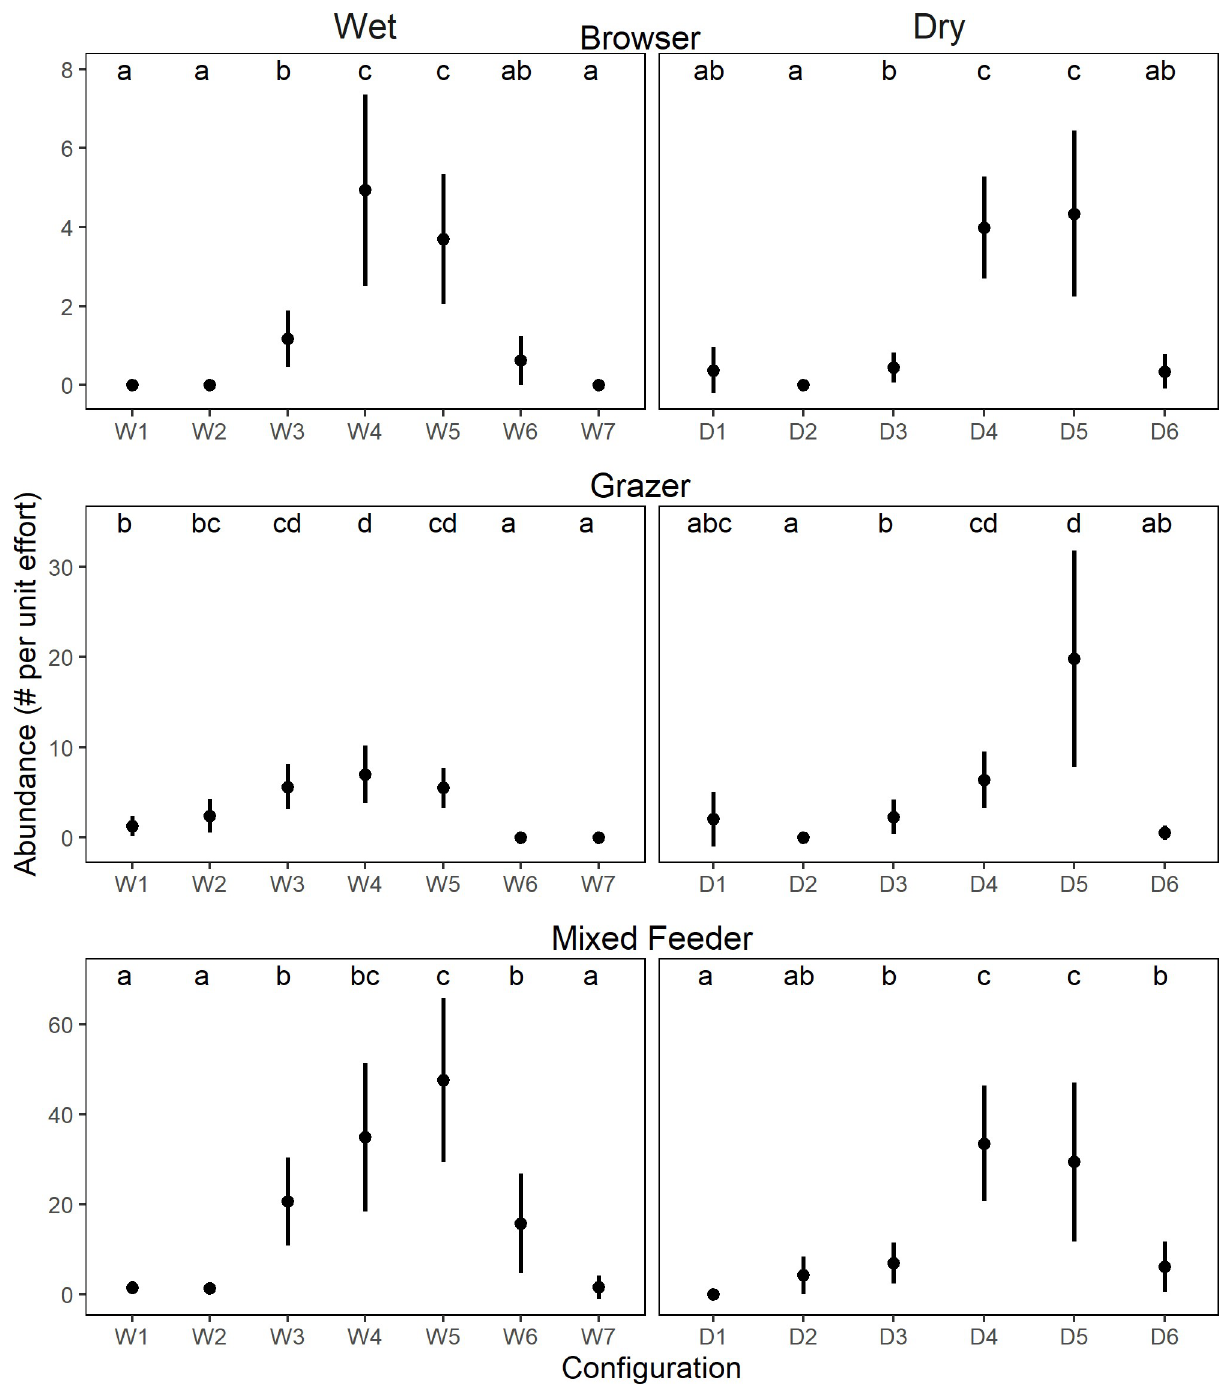
Fig 3. Species abundance (mean ± 95% CI) across configurations in the wet and dry seasons for each of the three feeding guilds. Configurations are organized by increasing woody plant cover (see Figs 1 and 2). Tukey’s honest significant difference tests reveal significant differences in abundance among the different configurations, as denoted by the lowercase letters within the data